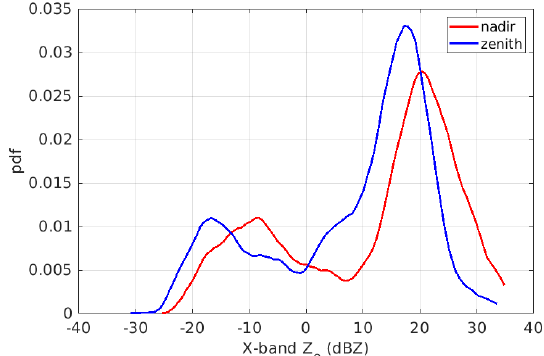
Figure 9. Probability density functions of the X-band reflectivities at 245m above and below the aircraft for the 22 November